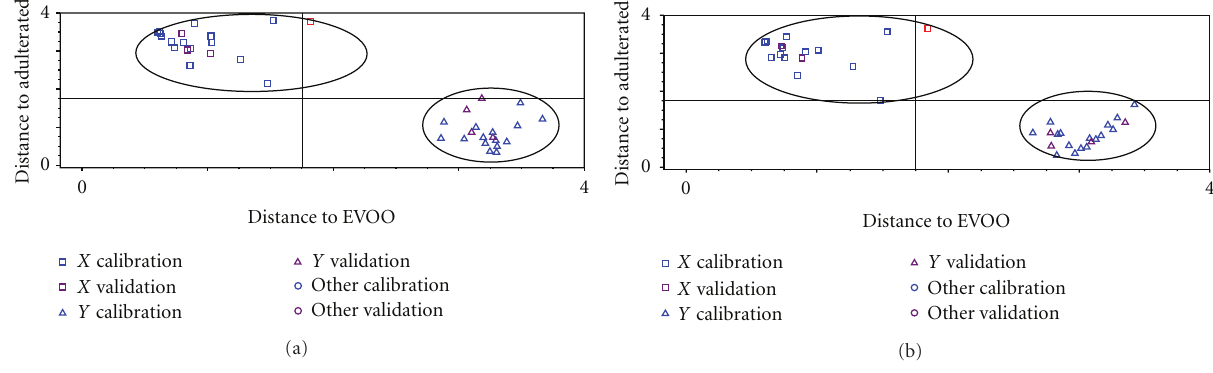
Figure 2: The Coomans plot for classification of EVOO and EVOO adulterated with corn oil (a) and with sunflower oil (b). Table 3: The performance of multivariate calibration (MC) and spectral treatments for analysis of corn oil in EVOO. Equation R